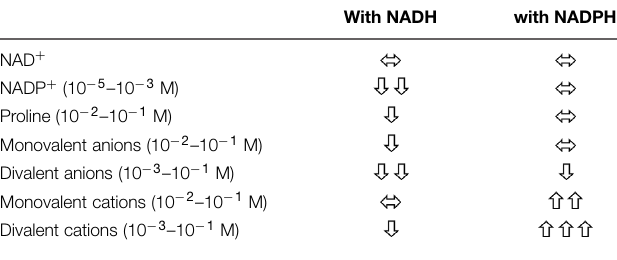
TABLE 3 | Effect of selected factors on the activity of rice P5C reductase depending on whether NADPH or NADH acts as co-substrate. With NADH with